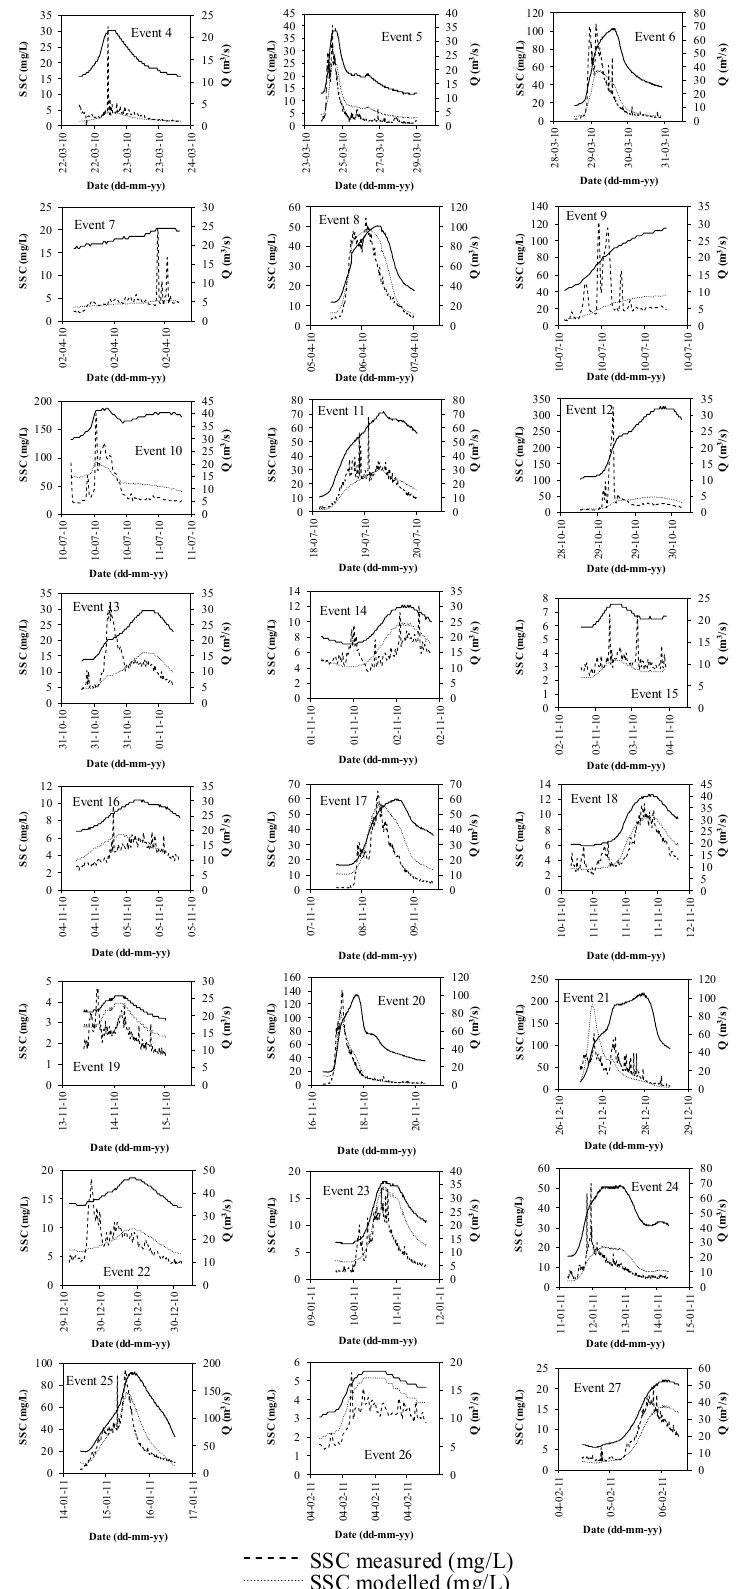
Figure 6. Measured and modeled suspended sediment concentration (SSC) concentration with the Vansickle and Beschta [2] modified model.